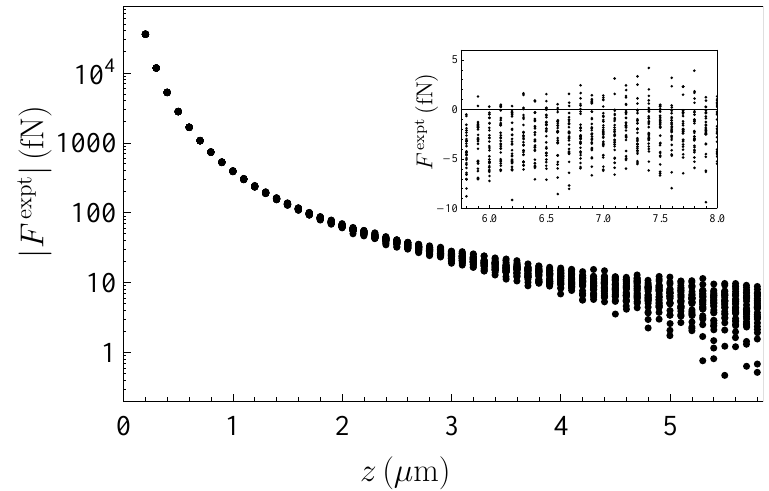
Figure 3. All measured magnitudes of the Casimir force between an Au-coated sphere and an Au-coated plate obtained from the first harmonic of the interaction as the plate rotates under the sphere are shown as a function of separation (in a logarithmic scale). The inset shows the force values over the region of large separations (in a linear